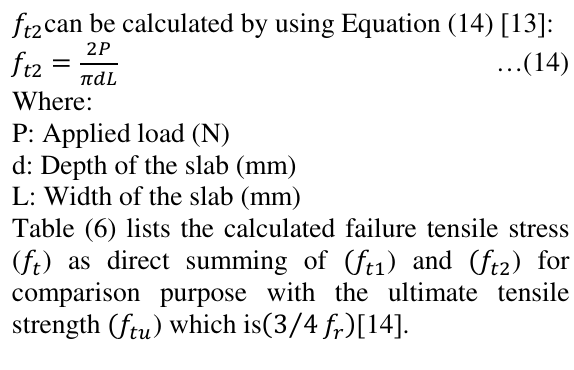
) and ) for (cid:10)* +- (cid:10)* +(cid:4)